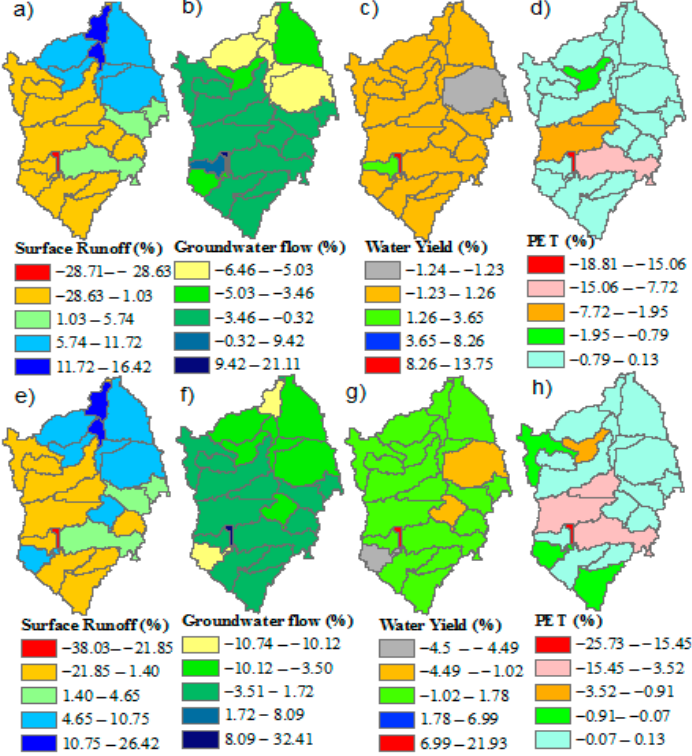
Figure 9. Spatial patterns of the changes in surface runoff, groundwater, water yield and PET due to LULCC. The top panel ( a , b , c and d ) shows the first scenario (2017–2036) and the bottom ( e , f , g and h ) shows the second scenario (2017–2055)